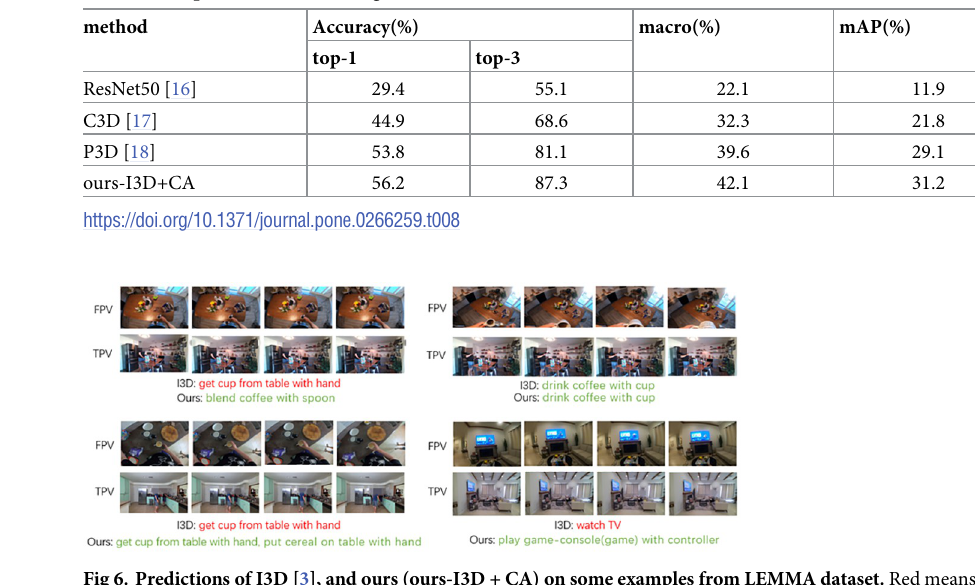
Fig 6. Predictions of I3D [3], and ours (ours-I3D + CA) on some examples from LEMMA dataset. Red means wrong prediction, green means correct